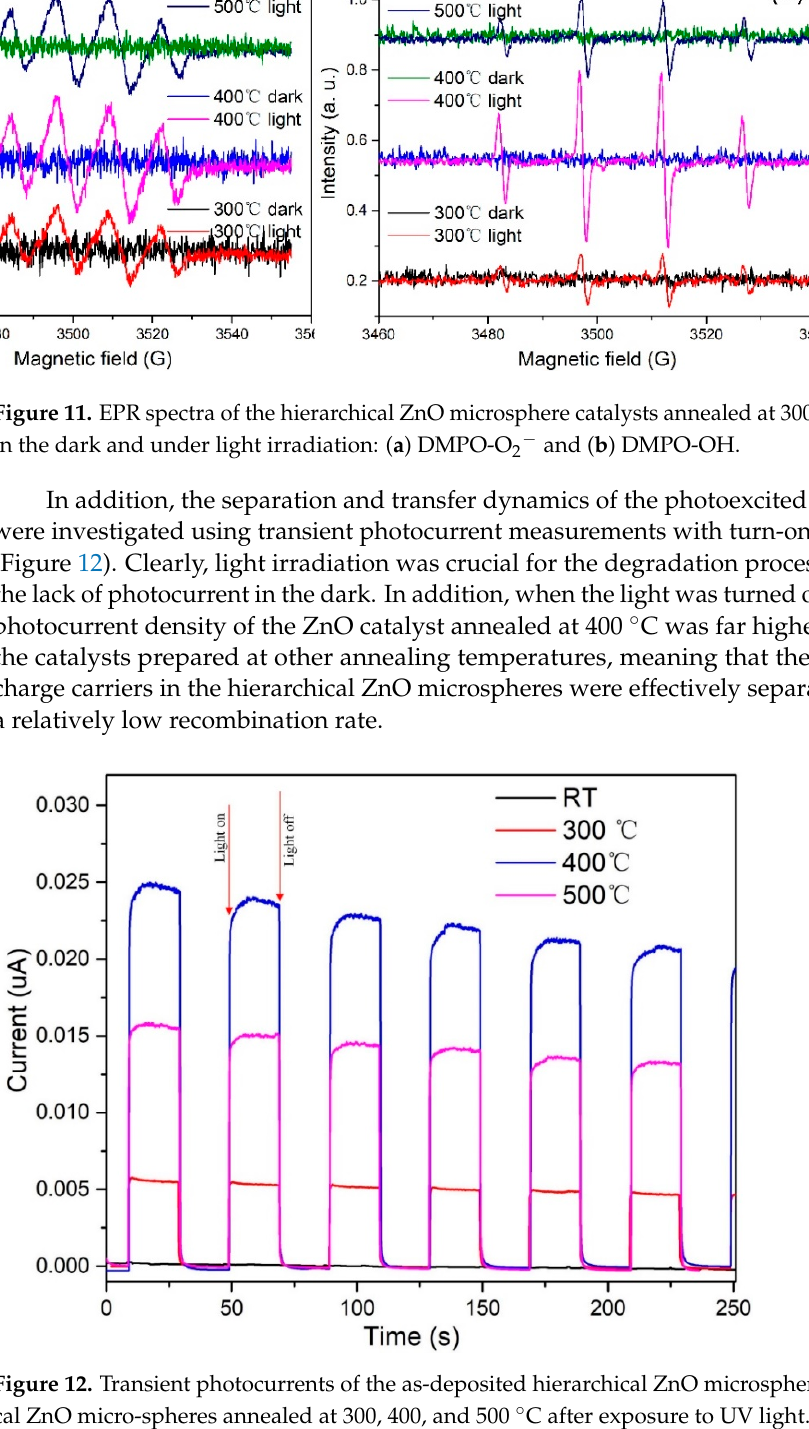
Figure 10. Schematic of the mechanism of photodegradation of organic dyes by the hierarchical ZnO microsphere catalyst.